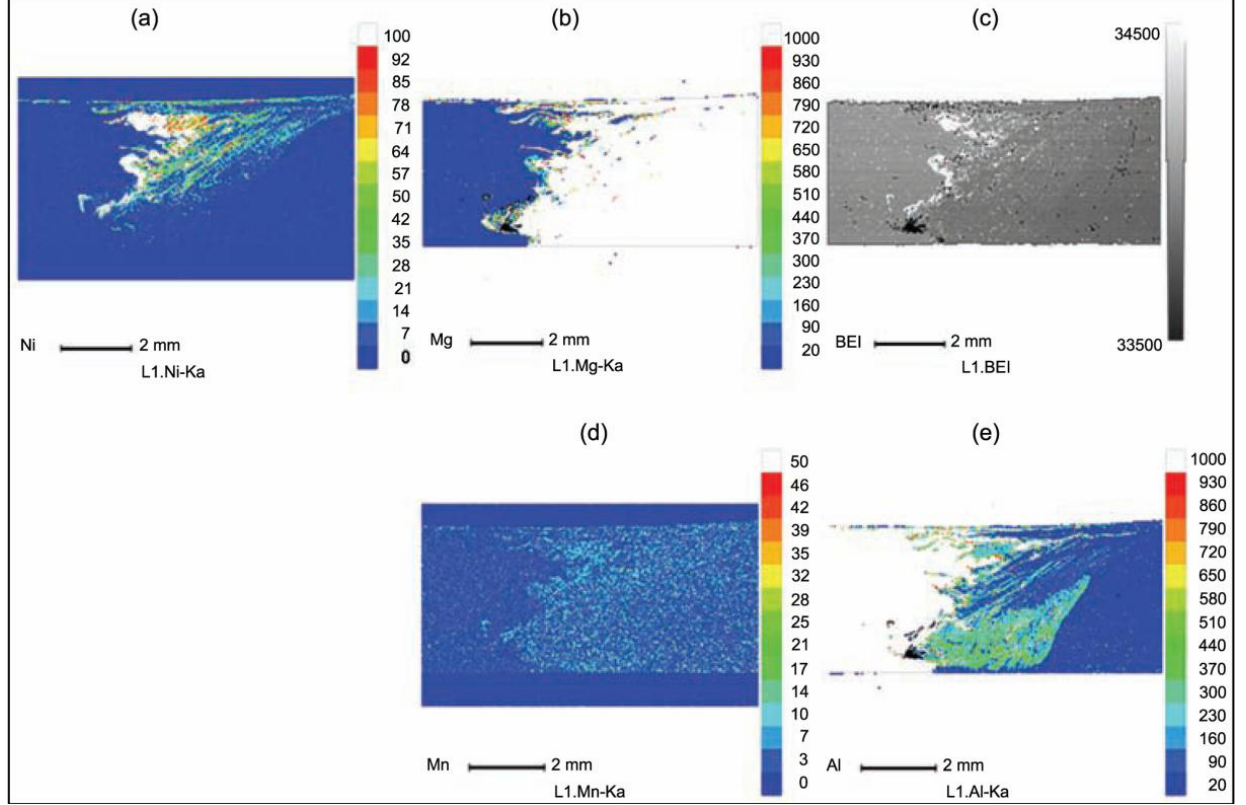
Figure 5. EPMA (Electron probe micro-analyzer) image and distribution maps of major elements of the dissimilar hybrid welded Al/Mg alloy with Ni-foil as interlayer [33]. ( a ) The distribution map of Ni; ( b ) the distribution map of Mg; ( c ) EPMA image; ( d ) the distribution map of Mn; ( e ) the distribution map of